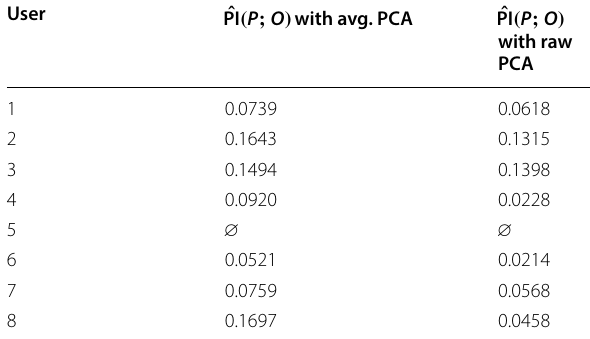
Table 1 Estimated PI values with maximum profiling